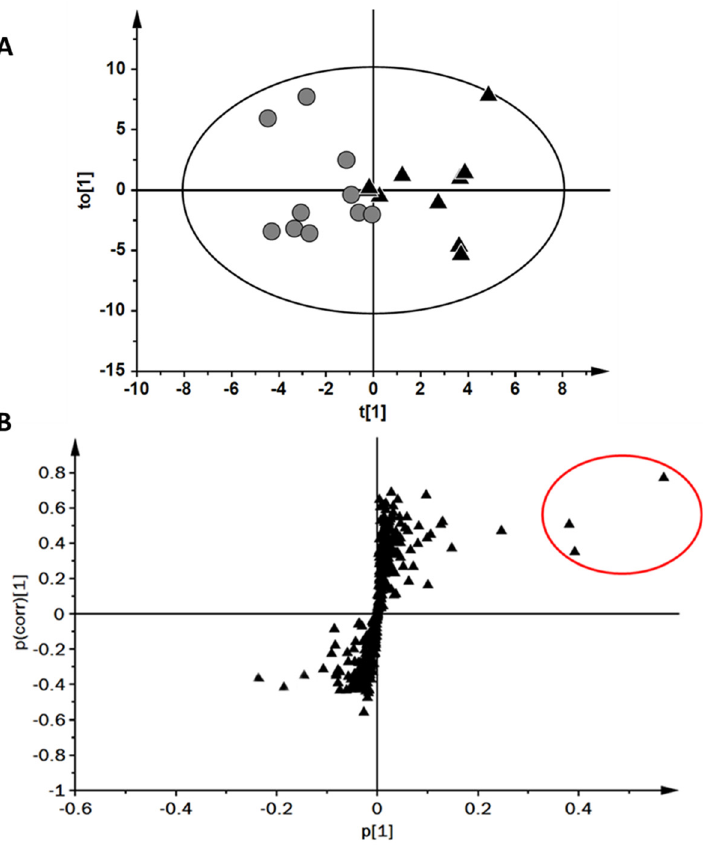
Figure 4. ( A ) Orthogonal partial least squares-discriminative analysis two-dimensional score plot constructed for breath samples for those falling into low (black triangles) and high (grey circles) absolute maximal oxygen uptake groups. ( B ) S-plot for modelled variables with candidate biomarkers highlighted in red ovals.